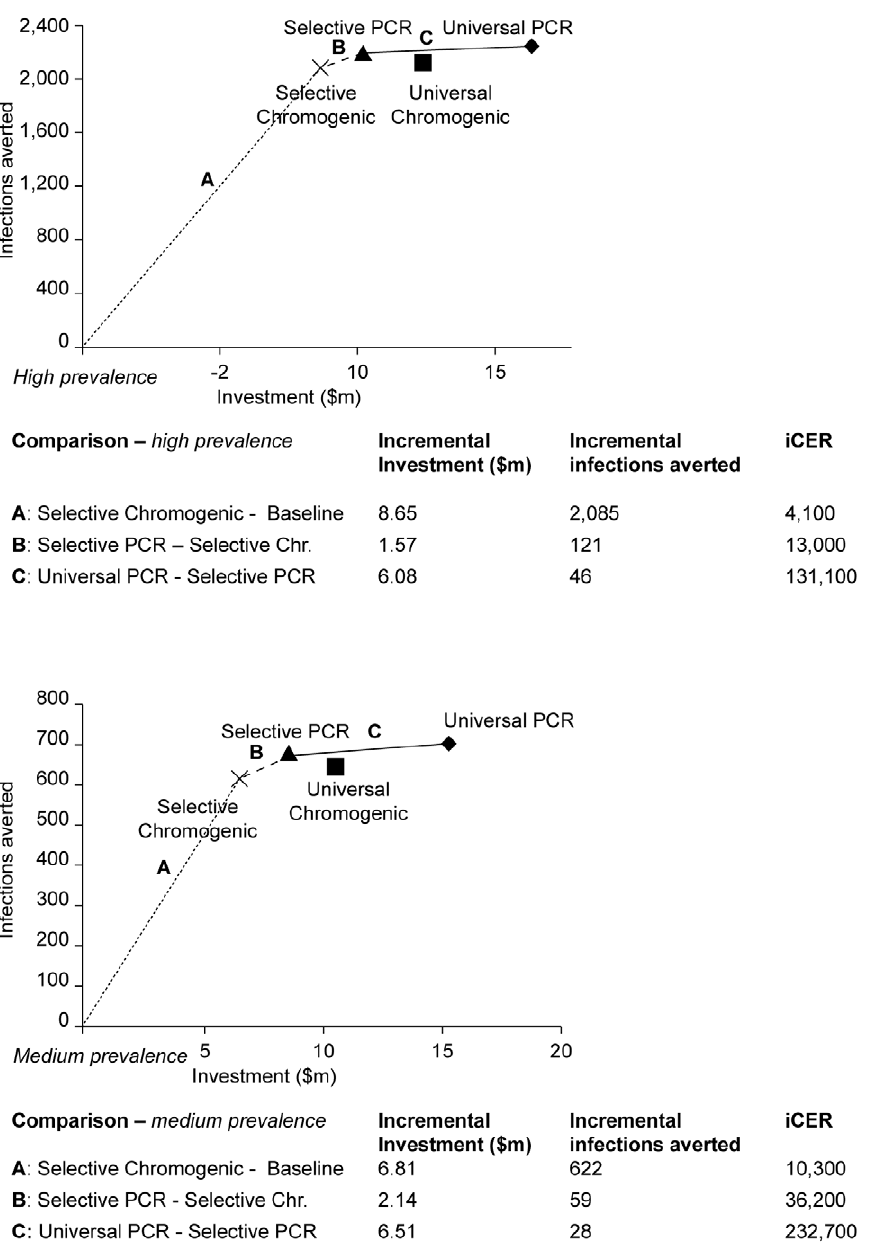
averted and investment costs of each screening strategy. The origin represents baseline, a policy of neither screening nor isolation. The incremental ratios of D effectiveness to costs are represented by the slopes of the lines connecting these points. The decreasing slope illustrates the diminishing return on investment when extending the selective PCR to universal screening in both settings. The strategy ‘Universal Chromogenic’ is dominated by ‘Selective PCR’ (higher costs, less health benefits), and is therefore not considered a relevant option. The incremental investment costs, infections averted and incremental cost-effectiveness ratio between selected strategies are shown in the table beneath the graphs. iCER incremental cost- effectiveness ratio; Chr .